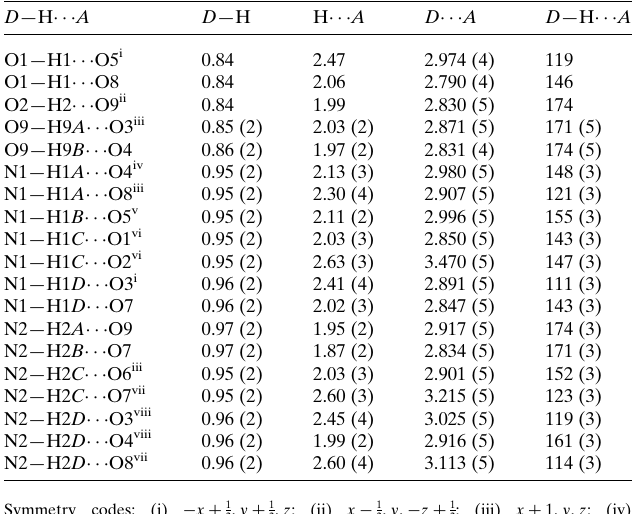
interacting (cid:3) -stacked tiron aryl groups, all in the crystal- lographic a -axis direction (Fig. 8).